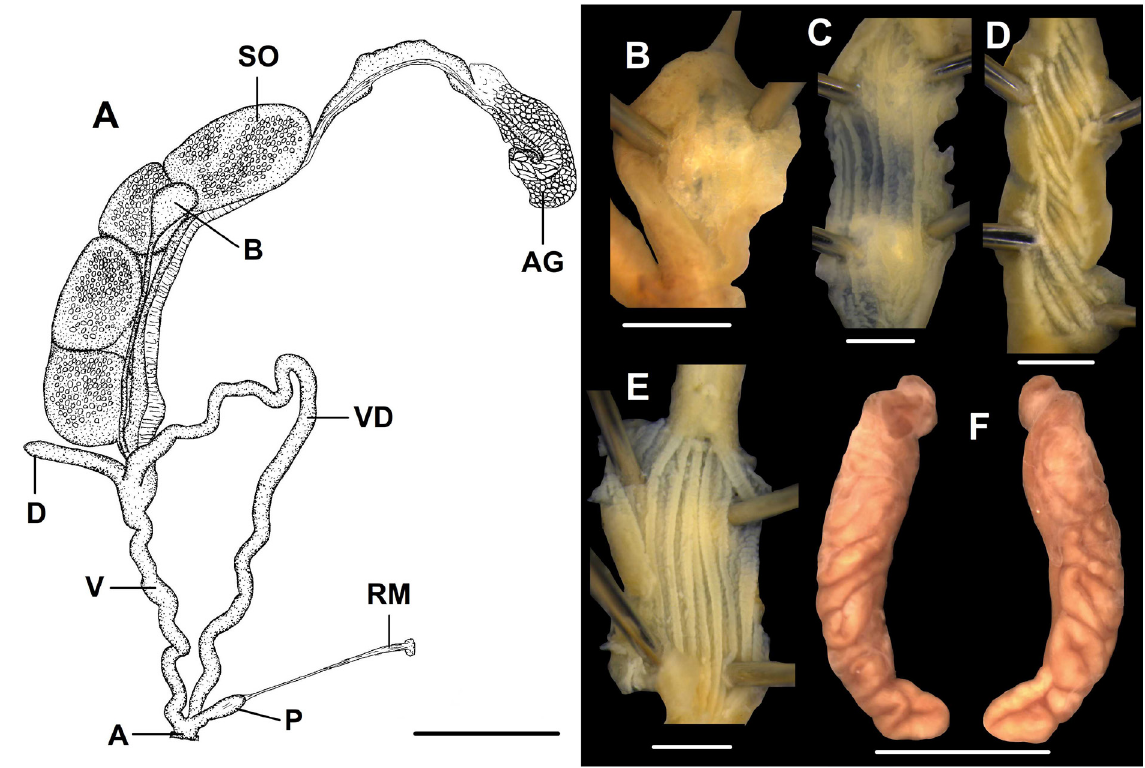
Fig. 10. Genitalia of Chersaecia dextrorsa (Benson, 1860) (FLMNH 76385). A . Whole genitalia. B–E . Inner structure of genital organs (B = penis, C = vagina, D = vas deferens, E = diverticulum). F . Both sides of a spermatophore. Scale bars: A = 5 mm; B–E = 0.5 mm; F = 2 mm. For abbreviations see Fig. 2. All photos: B.